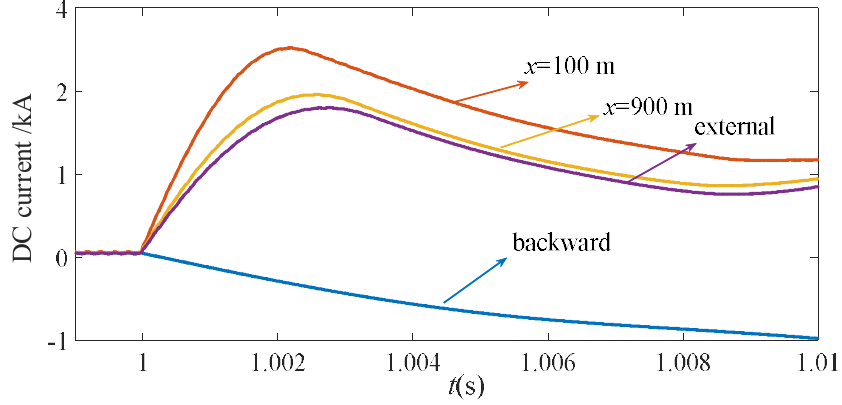
Figure 12. The DC current of pole-to-pole faults at different distances .